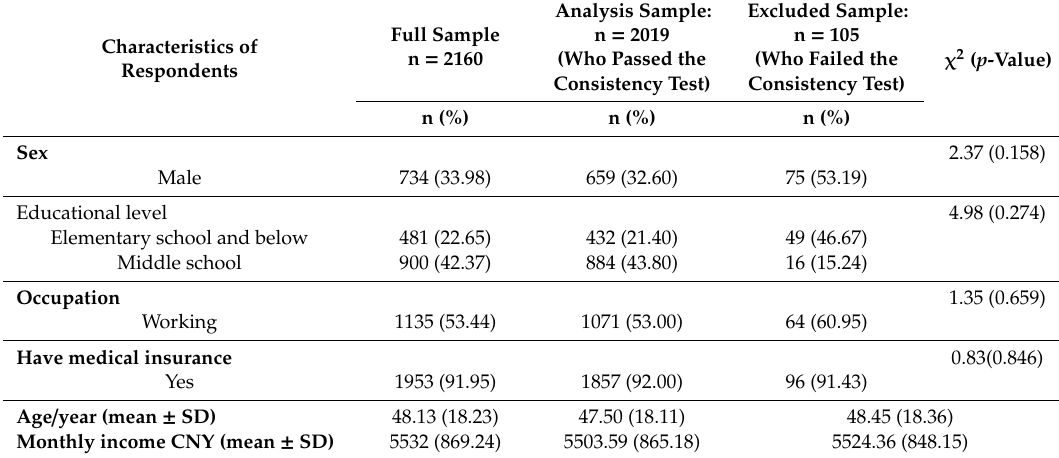
Table 3. Characteristics of